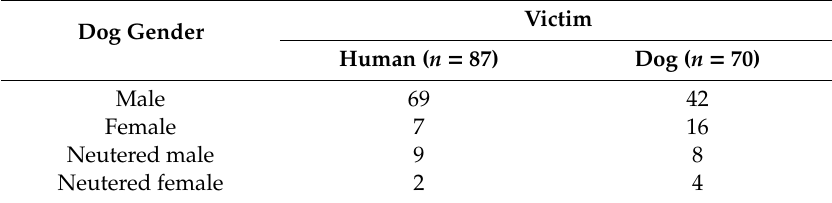
Table 24. Comparisons between dog gender and type of